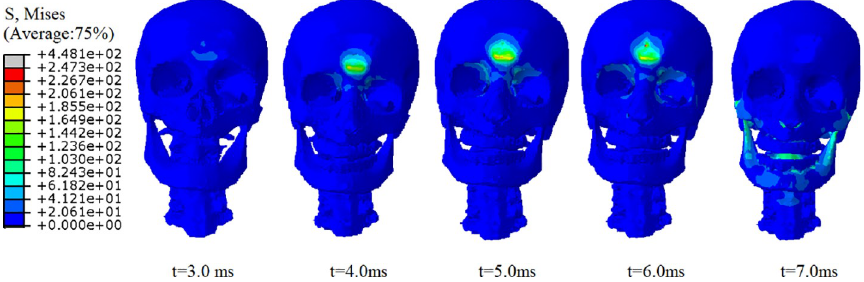
Fig 14. Propagation of stress wave in the skull under frontal collision. (A) t = 3.0 ms. (B) t = 4.0 ms. (C) t = 5.0 ms. (D) t = 6.0 ms. (E) t = 7.0